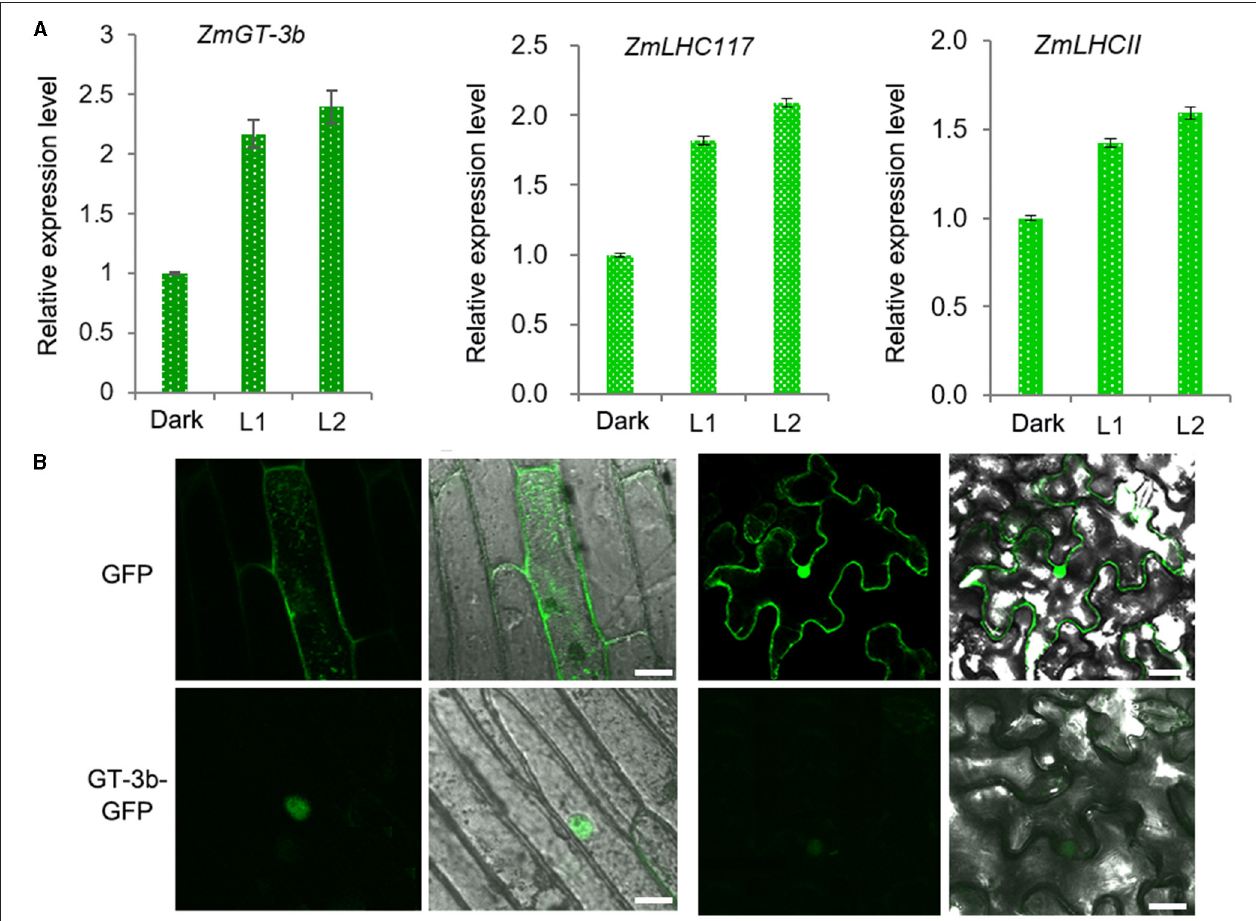
FIGURE 1 | Light-responsive ZmGT-3b expression and subcellular localization of ZmGT-3b. (A) The expression of ZmGT-3b , ZmLHC117 , and ZmLHCII (they are the two randomly selected typical light-responsive genes that encode the components of the light harvesting complex) is induced by light. “Dark” represents control seedlings (CK, maize inbred line LH244, wild type) that were grown in the dark for 5 days; L1 and L2 represent CK seedlings transferred to the light for 1 and 2h after 5 days of growth in the dark, respectively. Error bars denote the mean ± SD of n = 3 replicates. (B) ZmGT-3b-GFP localizes to the nucleus in onion epidermal cells and Nicotiana benthamiana leaves that were infiltrated with Agrobacterium tumefaciens carrying p35S : ZmGT-3b-GFP and observed 48h after infiltration. Green fluorescent protein (GFP) is the control transformed with an empty vector containing the p35S::GFP expression cassette in the pCAMBIA1300 backbone. The images were taken under a confocal microscope. Bar = 10 µ